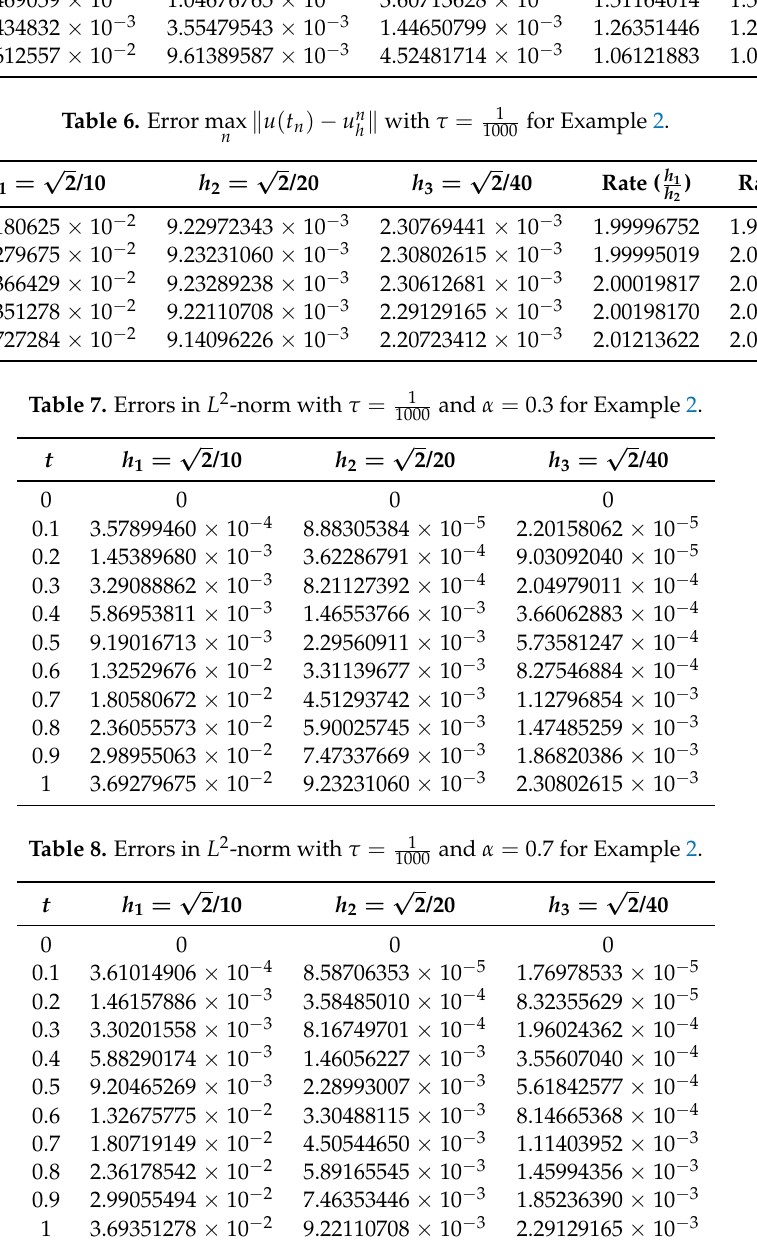
Table 6. Error max